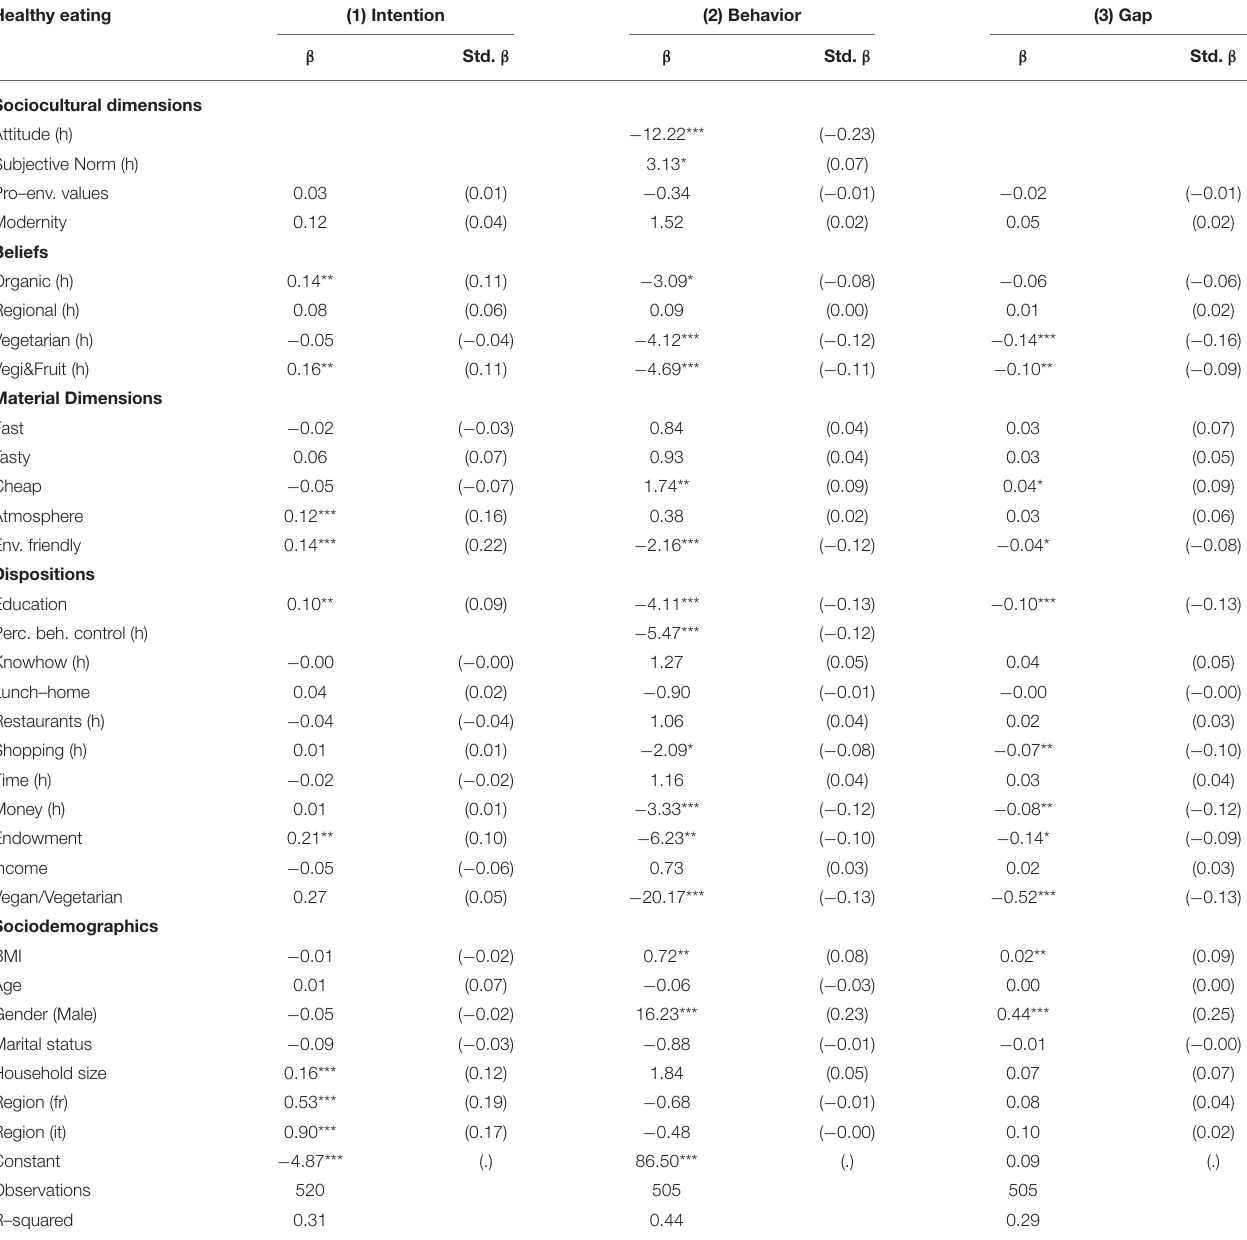
TABLE 4 | Linear regression analysis explaining the intention, behavior, and the gap between the two regarding healthy eating. Healthy eating (1) Intention (2) Behavior (3) Gap Std. β Std. β Std.